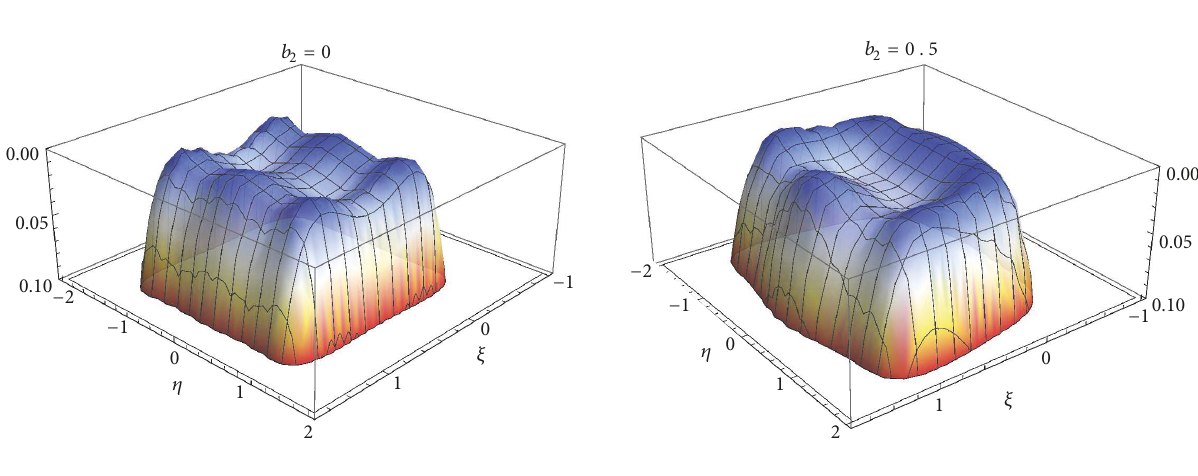
Figure 3: These graphics unveil upside down views of effective potential 𝑉(𝜉, 𝜂) , with 𝑏 2 = 0 (left panel) and 𝑏 2 = 0.5 (right panel).